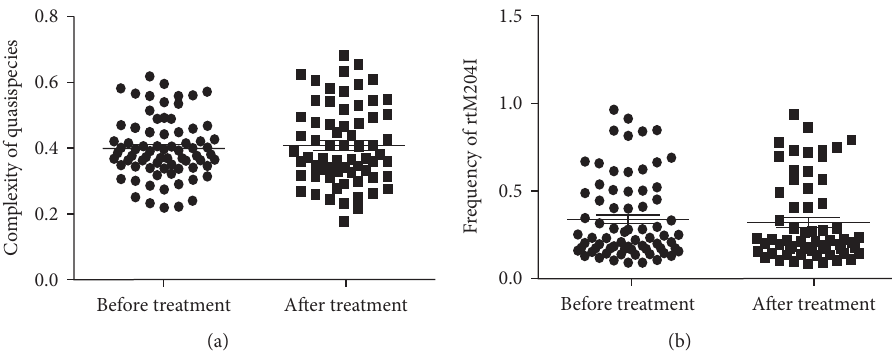
Figure 4: Impact of telbivudine short-time treatment to HBV mutations: (a) the change in HBV quasispecies complexity before and after telbivudine treatment; (b) the change in rtM204I mutation frequency before and after telbivudine